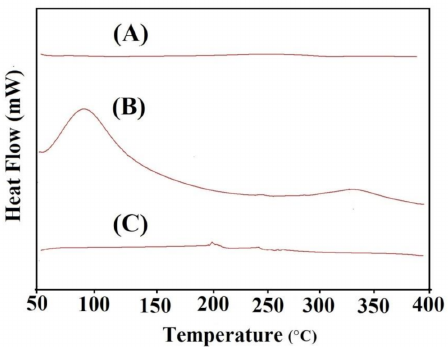
Figure 3. DSC of ( A ) CP, ( B ) SpS, and ( C ) CP/SpScPAA